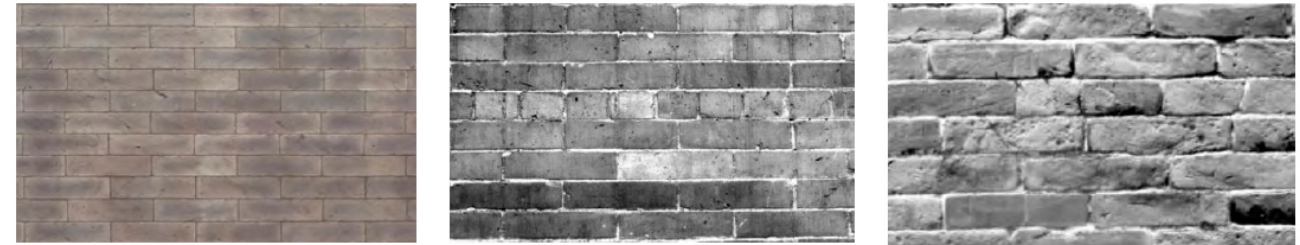
Figure 3. Three types of traditional gray-brick walls. From left to right: silk seam (ground brick joint) wall, grinding wall, rough masonry wall. (Image Source: Atlas of Restoration of Historic Buildings in Guangzhou).